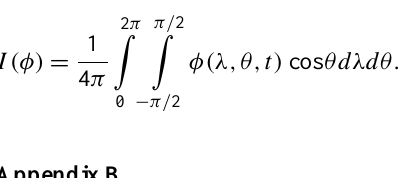
‘Real’ mixing is defined as numerical mixing that resembles ‘real’ mixing in that values are shifted to the concave side of